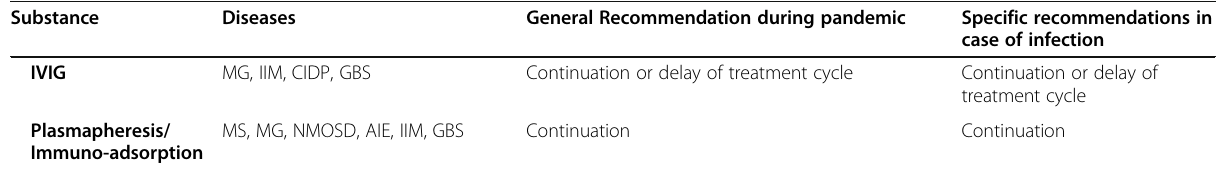
Table 1 Overview of the most frequently applied immunotherapies for neurological diseases and corresponding recommendations regarding their application in times of COVID-19